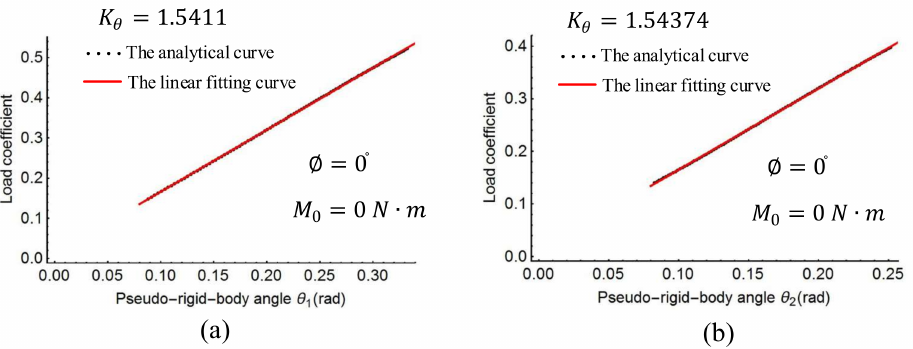
Figure 11. Linear regression of stiffness coefficient with action force: ( a ) rotation joints P 1 , ( b ) rotation joint P 2 .